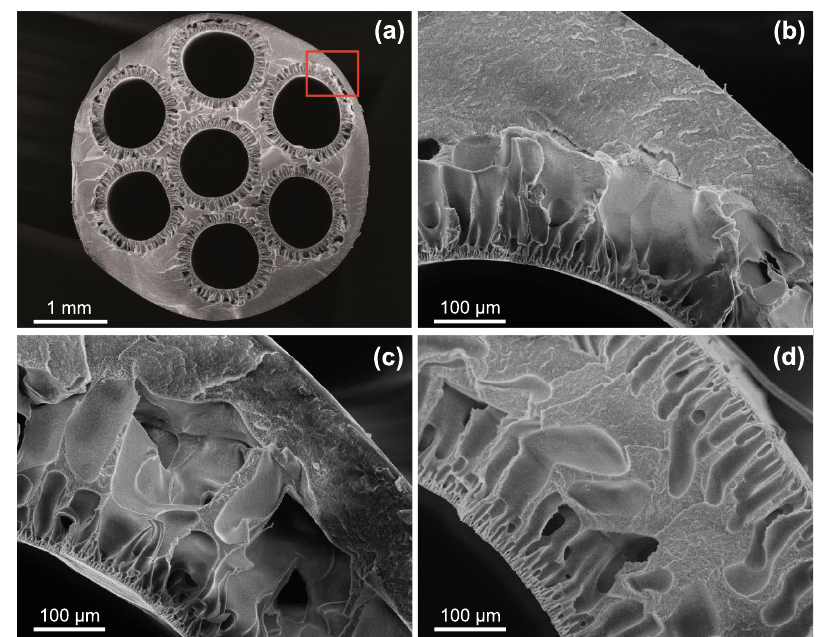
Figure 3. Cross sectional scanning electron microscope (SEM) images. ( a , b ) M W PVP = 10 kDa